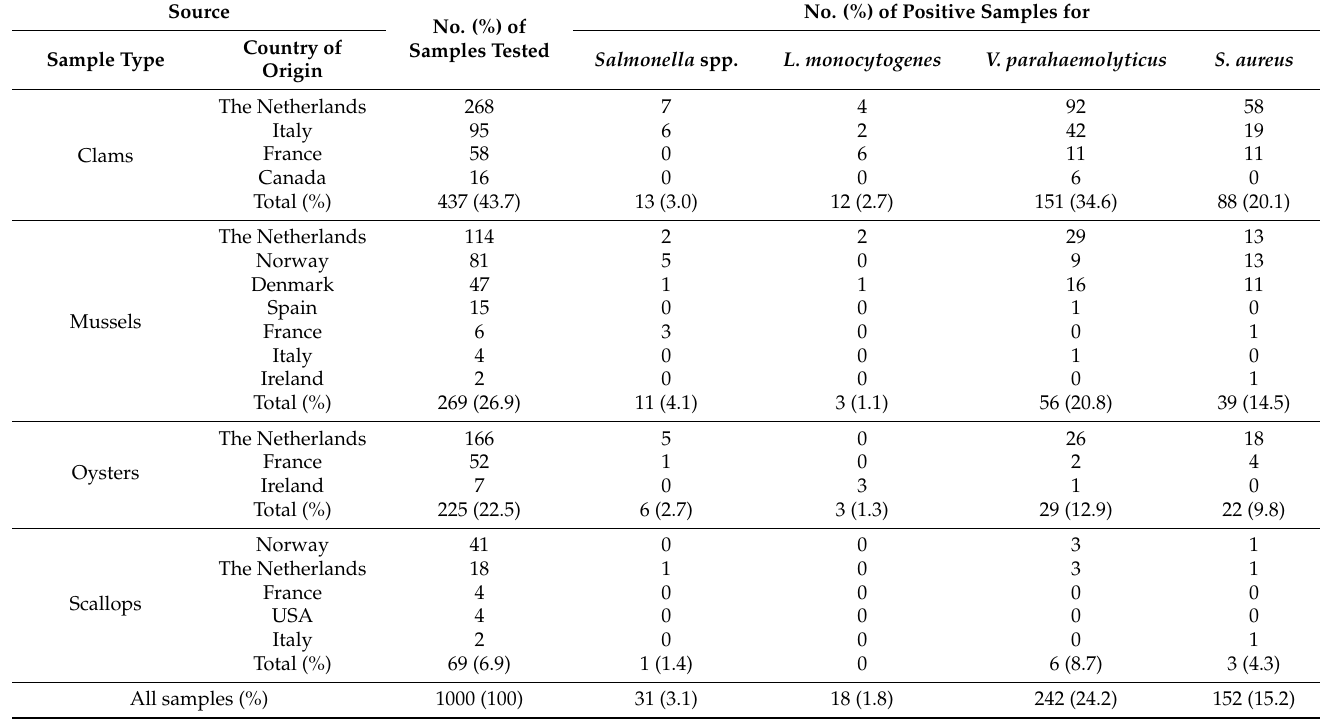
Table 3. Prevalence of bacterial pathogens in the different types of bivalve molluscs tested. No. (%) of Samples